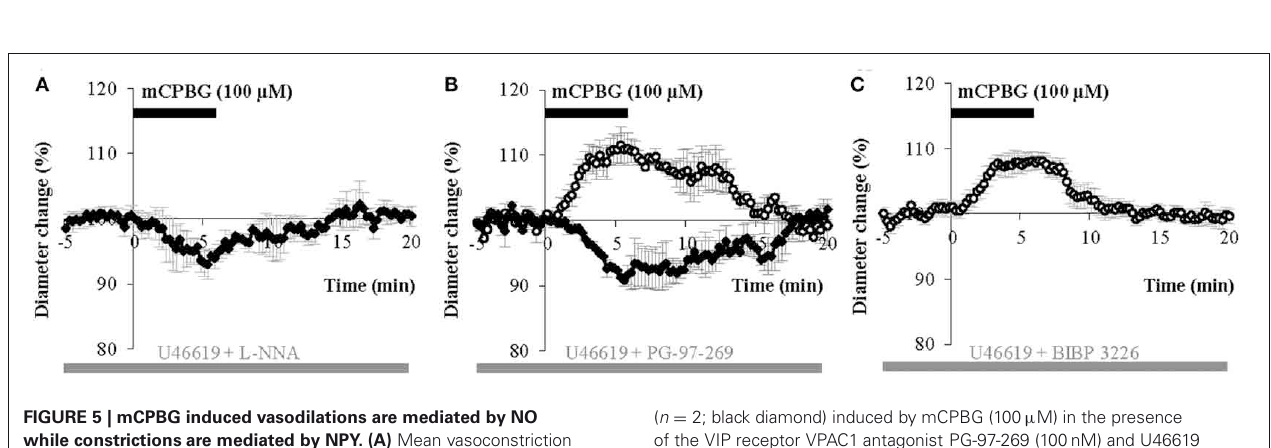
FIGURE 4 | mCPBG induces both vasodilations and vasoconstrictions in somatosensory cortical slices. (A) Mean vascular dilation ( n = 9) induced by mCPBG (100 μ M). (B) Infrared images of a penetrating blood vessel that reversibly dilated in response to bath application of mCPBG (100 μ M). Arrows